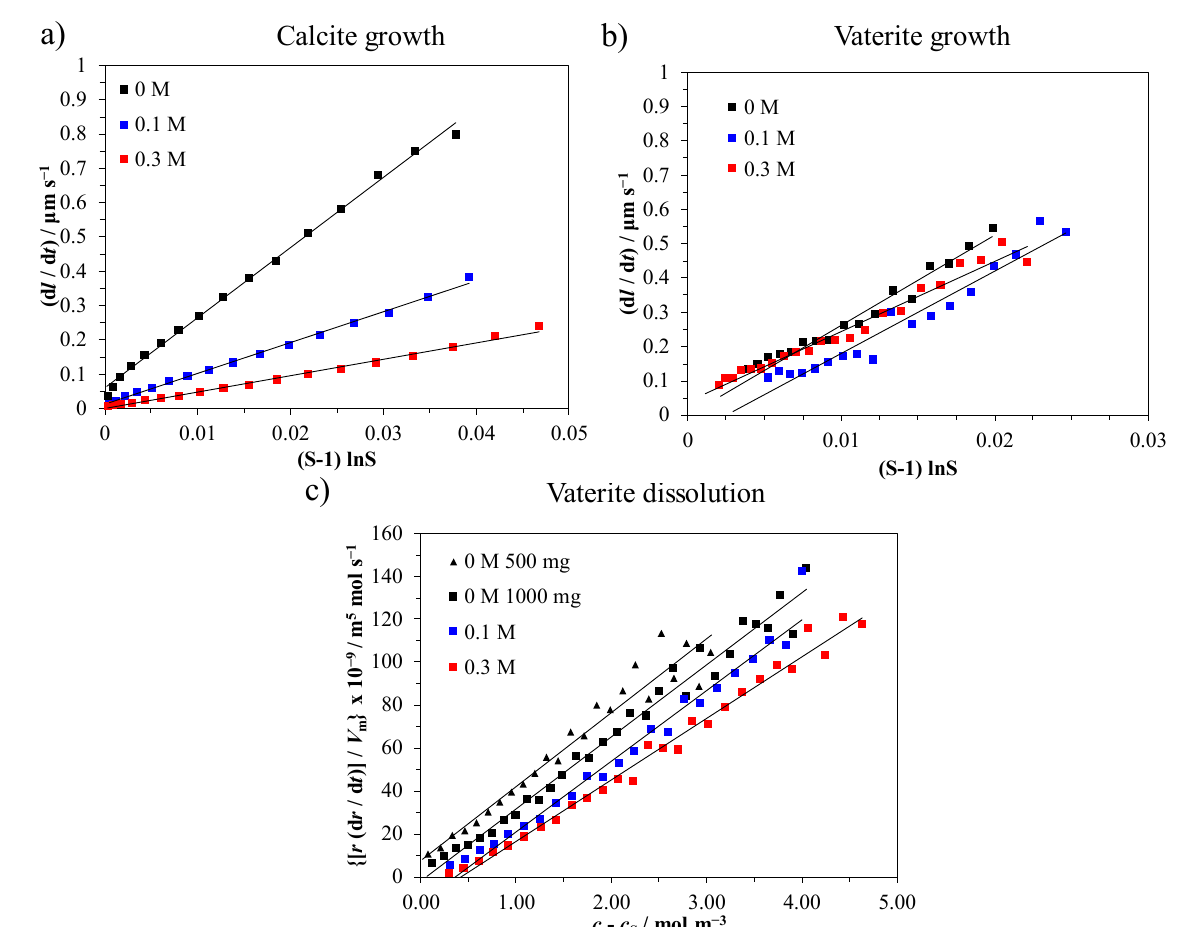
Figure 7. Plot of growth rates as a function of supersaturation expressed as ( S − 1) ln S , for ( a ) growth of calcite and ( b ) vaterite seed and ( c ) c − c S for the dissolution of vaterite, where c s is solubility of respective polymorph and S = ( c / c S ). The mass concentrations or calcite and vaterite were, γ (calcite) = 125 mg L − 1 and γ (vaterite) = 125 mg L − 1 respectively. Plots correspond to data shown in Figure 6.